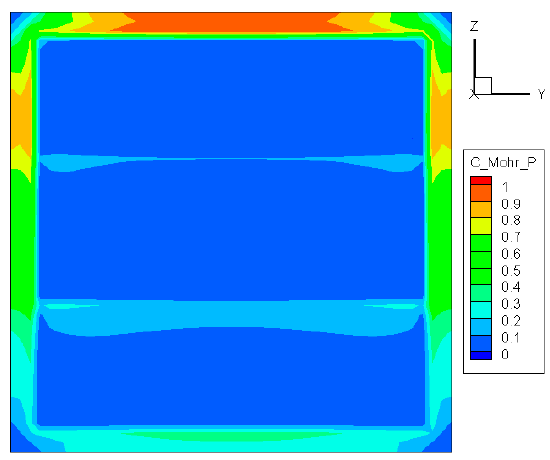
Figure 6. Distribution of σ 1 / S ut − σ 3 / S uc before crack initiation.